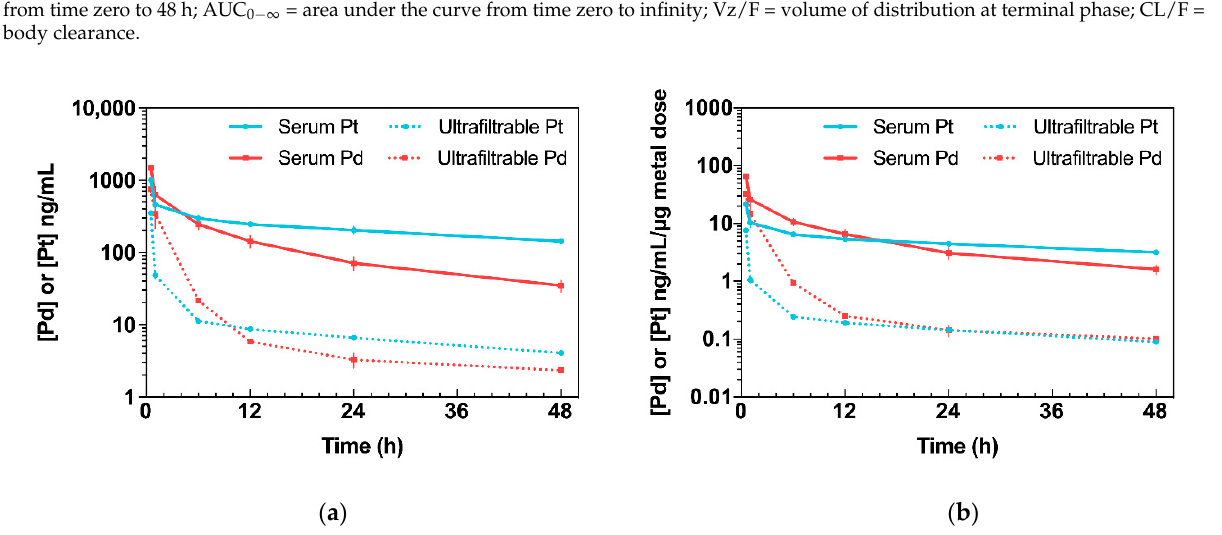
Figure 2. Kinetic profiles of Pd (from Pd 2 Spm, 3 mg/kg bw) and Pt (from cisplatin, 3.5 mg/kg bw) in serum and serum ultrafiltrate after single intraperitoneal bolus injection in Balb/c mice. Data are expressed as mean ± SEM ( n = 5 animals per time point). ( a ) Concentration–time plot of mean Pd or Pt levels in serum and serum ultrafiltrate. ( b ) Concentration–time plot of mean Pd or Pt levels in serum and serum ultrafiltrate normalized to administered metal dose.